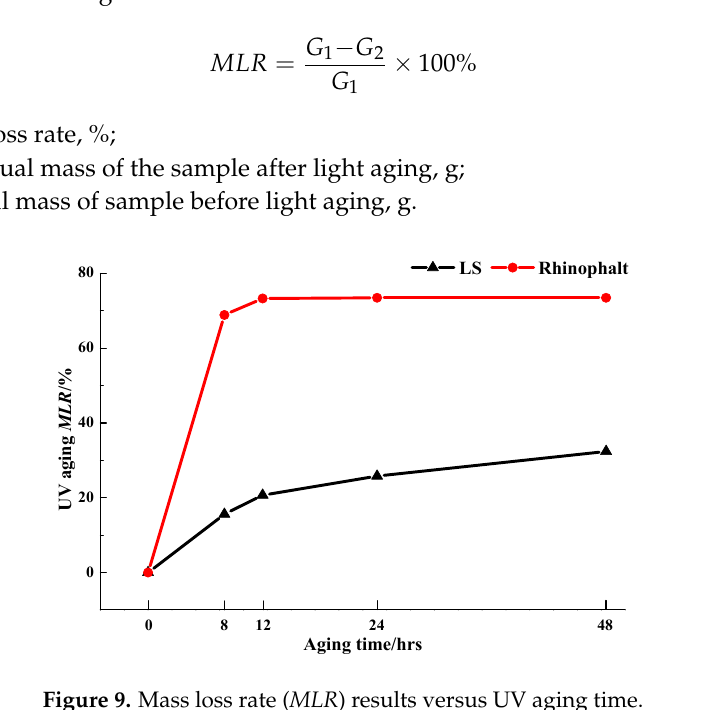
Figure 9. Mass loss rate ( MLR ) results versus UV aging time.